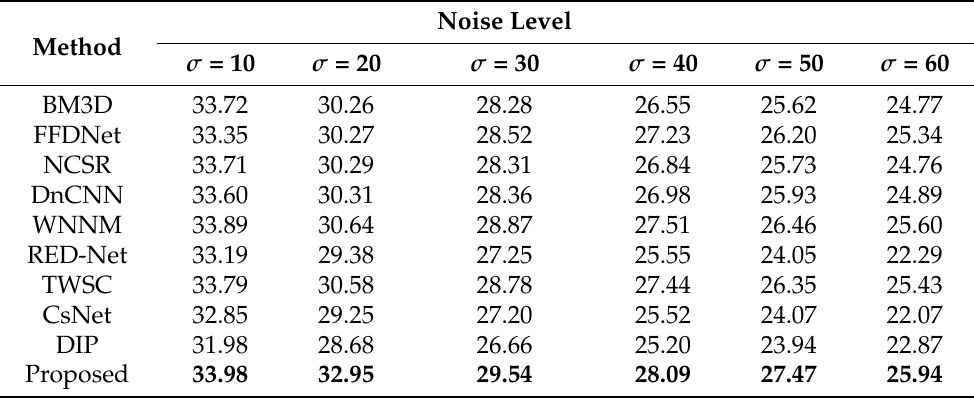
Table 15. Average PSNR results of different methods on 10 images in Urban100 with various noise levels.